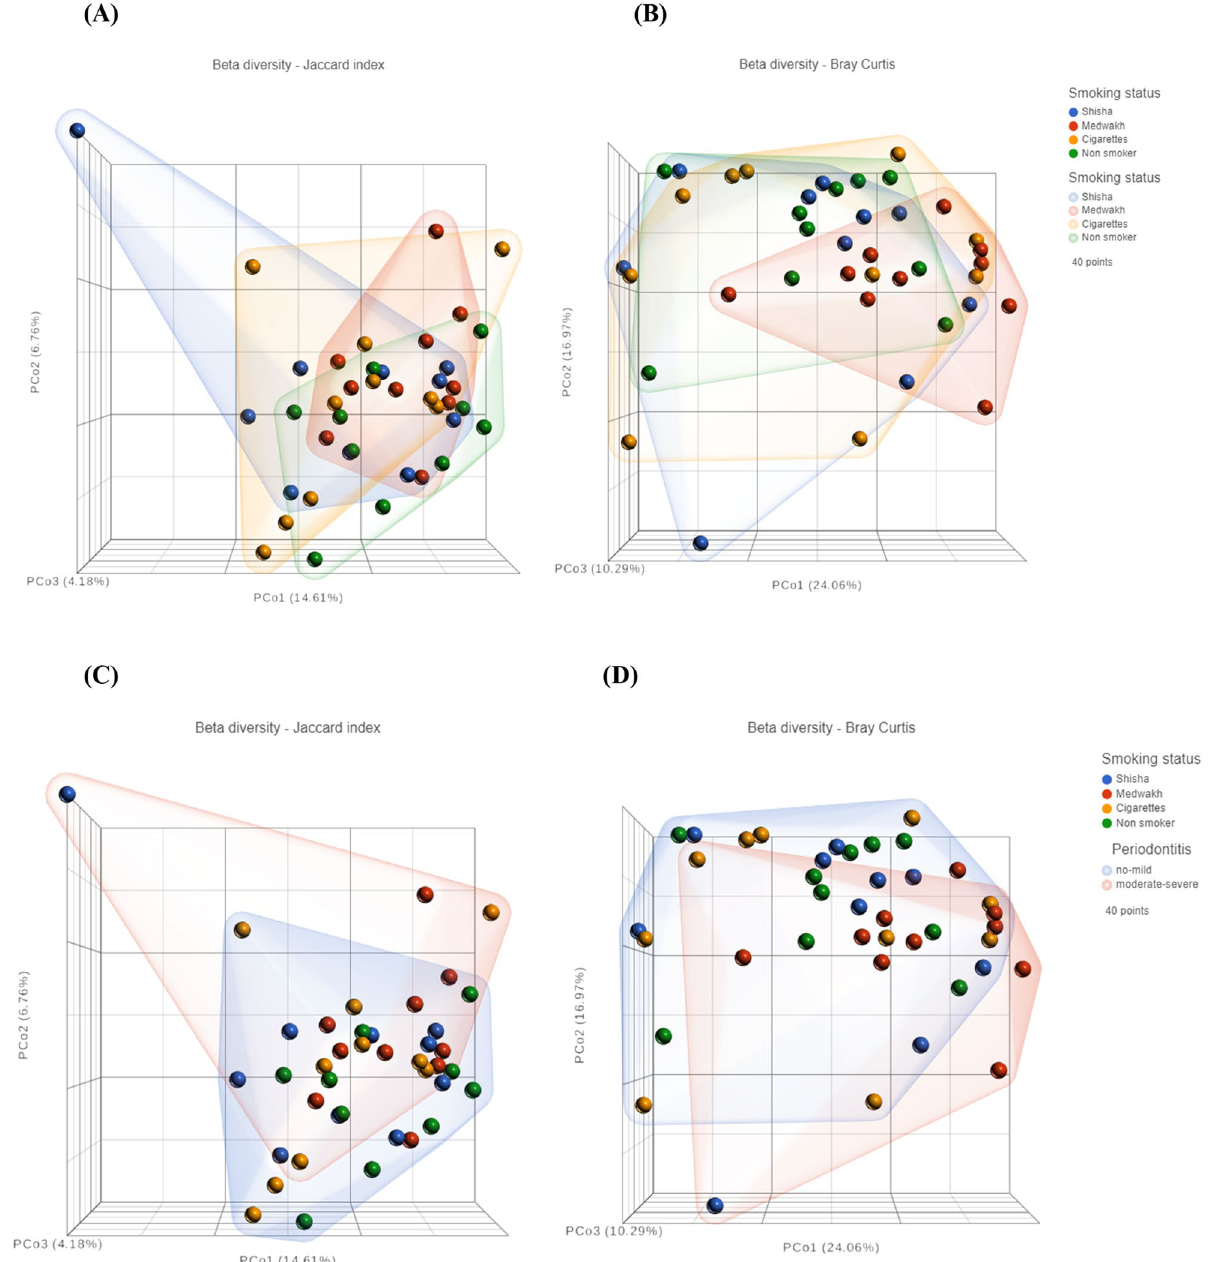
Figure 6. Beta diversity ( A – D ) and alpha diversity ( E – J ) of 40 subgingival plaque samples. For beta diversity, Jaccard index ( A , C ) and Bray–Curtis index ( B , D ) are shown. Samples were clustered based on principal coordinates analysis (PCoA). In ( A , B ), samples were highlighted by smoking group, and in ( C , D ), samples were highlighted based on periodontal condition. PCo1, PCo2 and PCo3 are shown in the figures. The percentage of variation explained by each principal coordinate is indicated on the axes. Each point represents a microbial community from one sample. For alpha diversity ( E – J ), samples were grouped based on both smoking status and periodontal